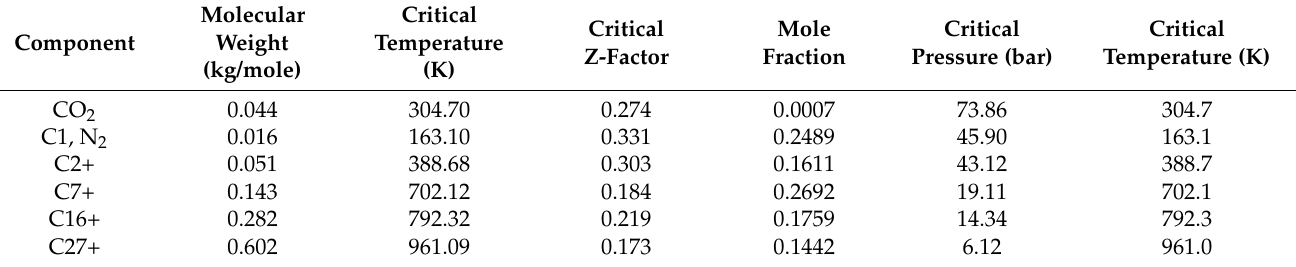
Table 2. Composition description of